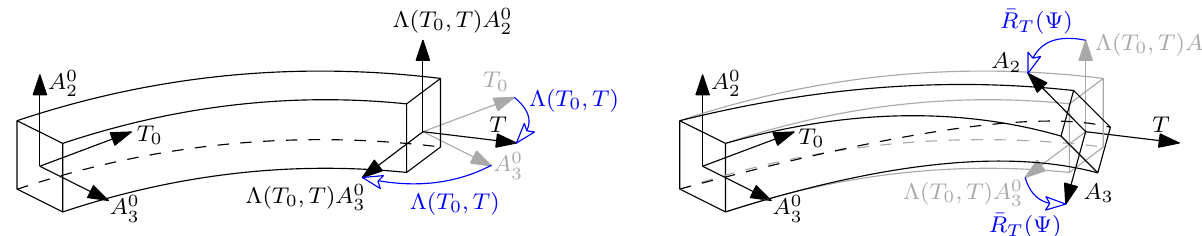
Figure 3. The Λ ( T 0 , T ) and ¯R T ( Ψ ) operations used for the alignment of the Bernoulli beam cross-section at the current position.